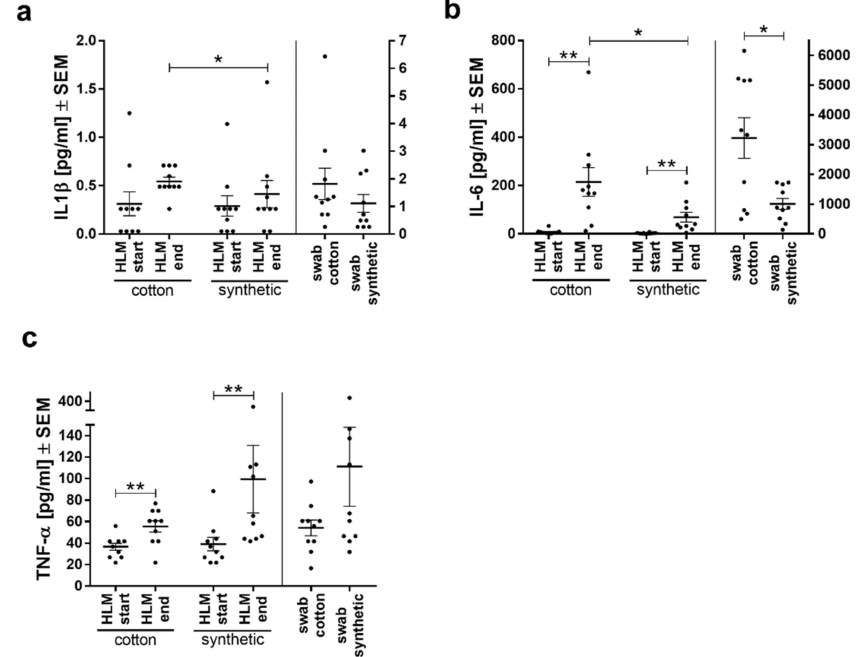
Figure 4. Interleukin levels of ( a ) IL1 β and ( b ) IL6 from patients of both groups (cotton swabs and synthetic swabs) were lower with synthetic abdominal swabs than with cotton swabs, while no differences were seen with ( c ) TNF α secretion. Cytokine levels are presented as means ± SEM per study group. * p <0.05, ** p < 0.01, student’s t